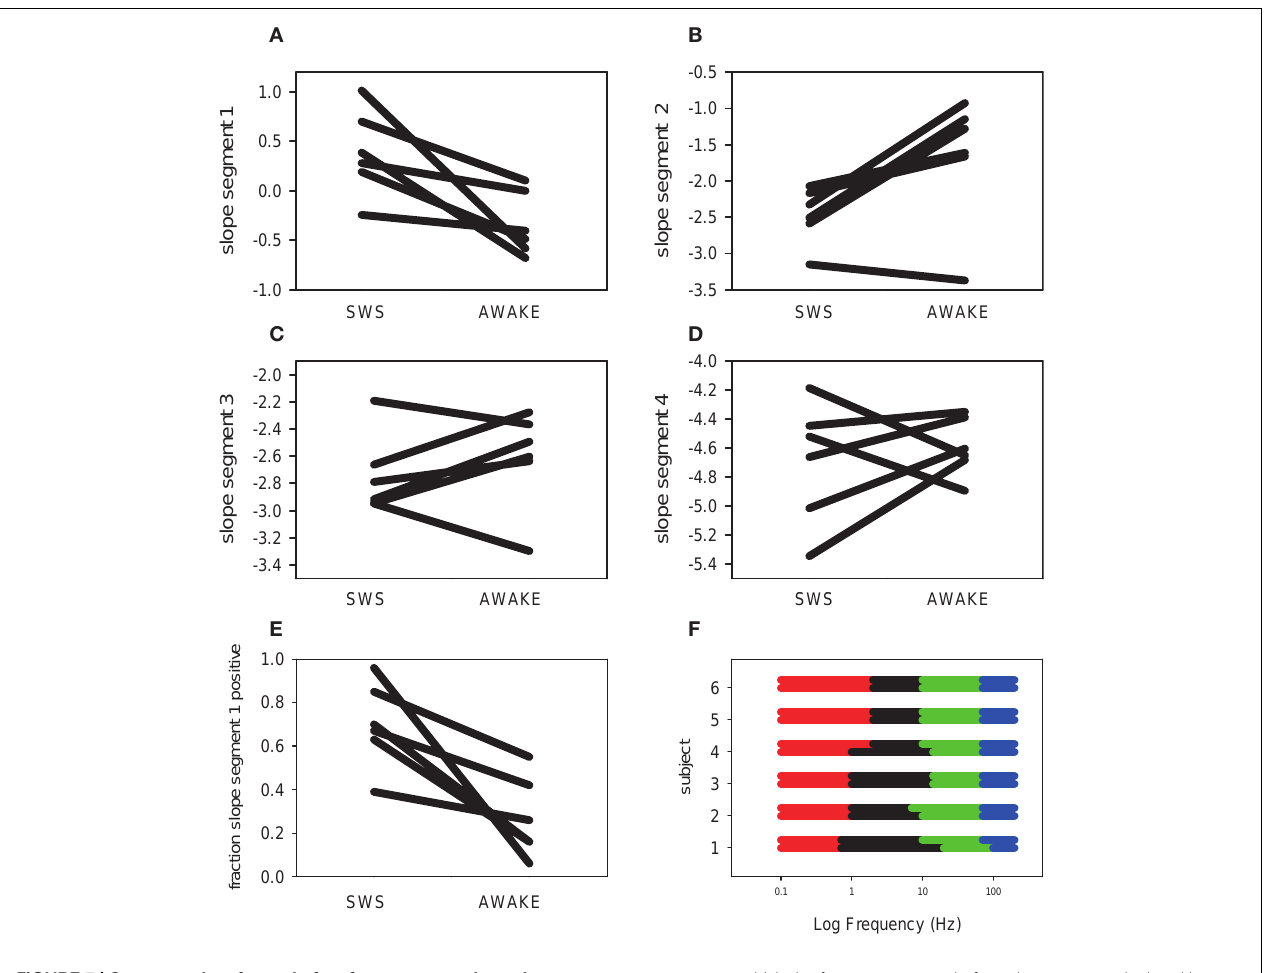
FIGURE 7 | Summary data for scale-free four segment slopes in SWS and awake states. Each line is a separate subject. (A) Segment one slope (B) Segment two slope (C) Segment three slope (D) Segment four slope. (E) Fraction of positive segment one slopes. (F) Frequency